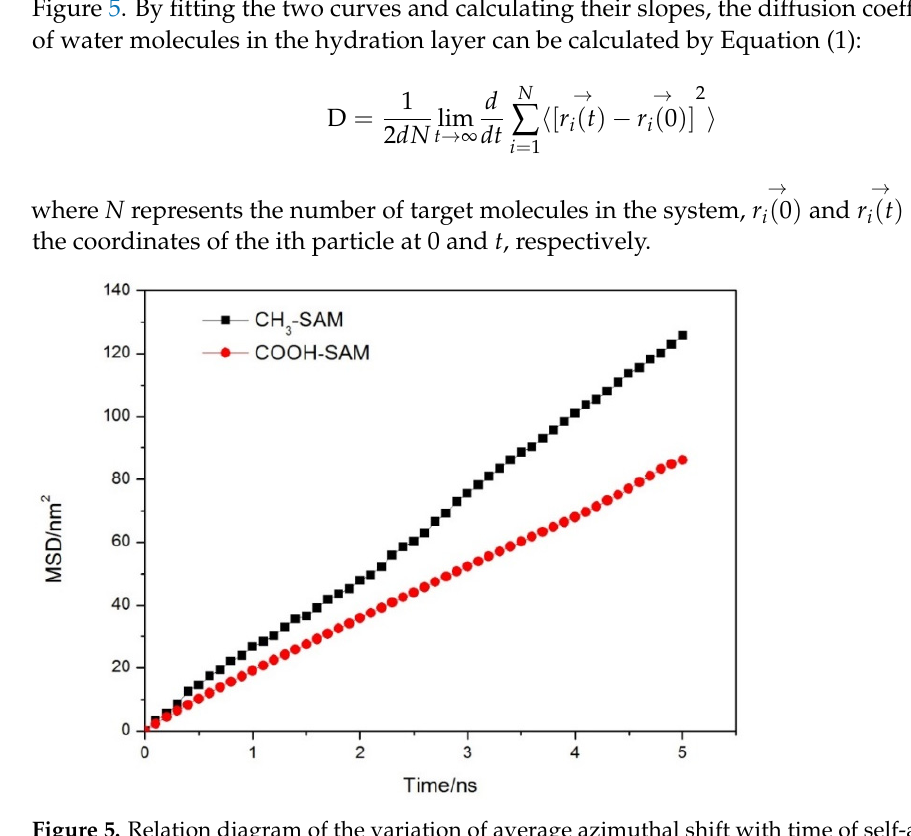
Figure 5. Relation diagram of the variation of average azimuthal shift with time of self-assembled membrane surface hydration layer molecules.